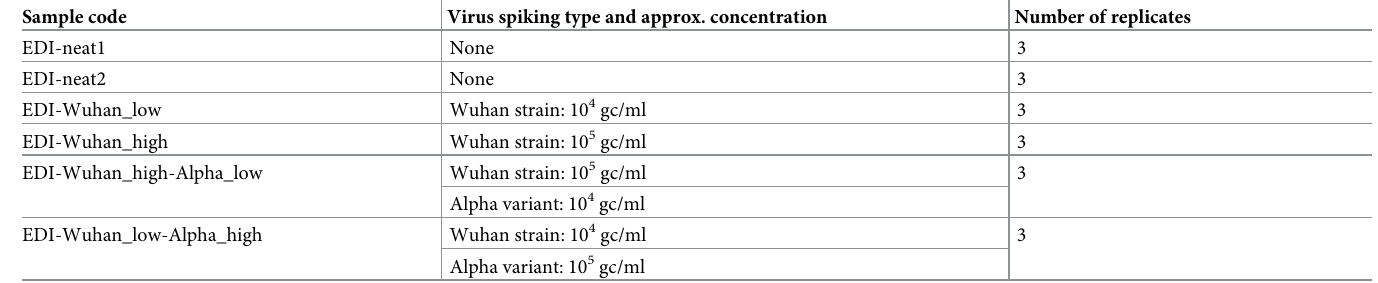
Table 1. Samples (taken at Edinburgh airport wastewater treatment plant inlet point) spiked with the Wuhan strain and the Alpha variant for SARS-CoV-2 for the study (gc: Genome copies). Sample code